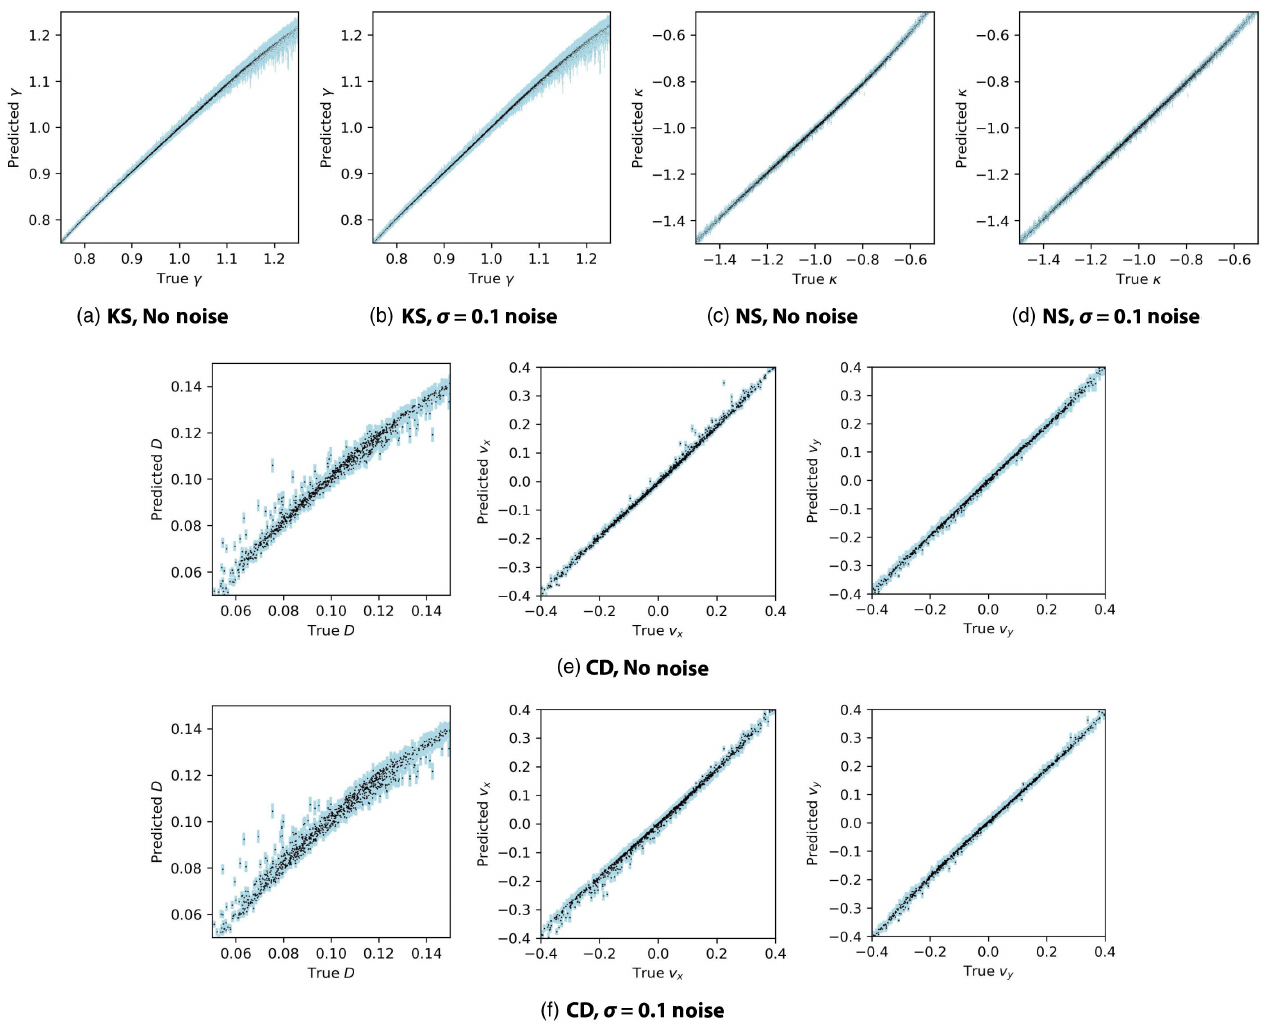
FIG. 3. Predicted physical parameters from a linear fit with the relevant latent parameter (Fig. 2) versus the ground truth physical parameters from the (a),(b) 1D Kuramoto-Sivashinsky, (c),(d) 1D nonlinear Schrödinger, and (e),(f) 2D convection-diffusion datasets. Because the drift velocity v from the CD dataset has an inherent rotational symmetry, they are encoded in a two-dimensional latent subspace (Table II), so we instead show the predicted drift velocity components v subspace of two relevant latent parameters, which extracts the linear combination of latent parameters that correspond to v The light blue shaded bars are the 95% confidence intervals produced by the models. Results are shown for models trained on (a),(c),(e) the original noiseless datasets as well as (b),(d),(f) the datasets with added σ ¼ 0 . 1 Gaussian